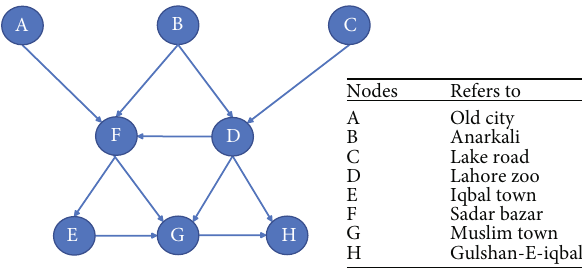
Figure 6: Sample graph 1 for datasets.